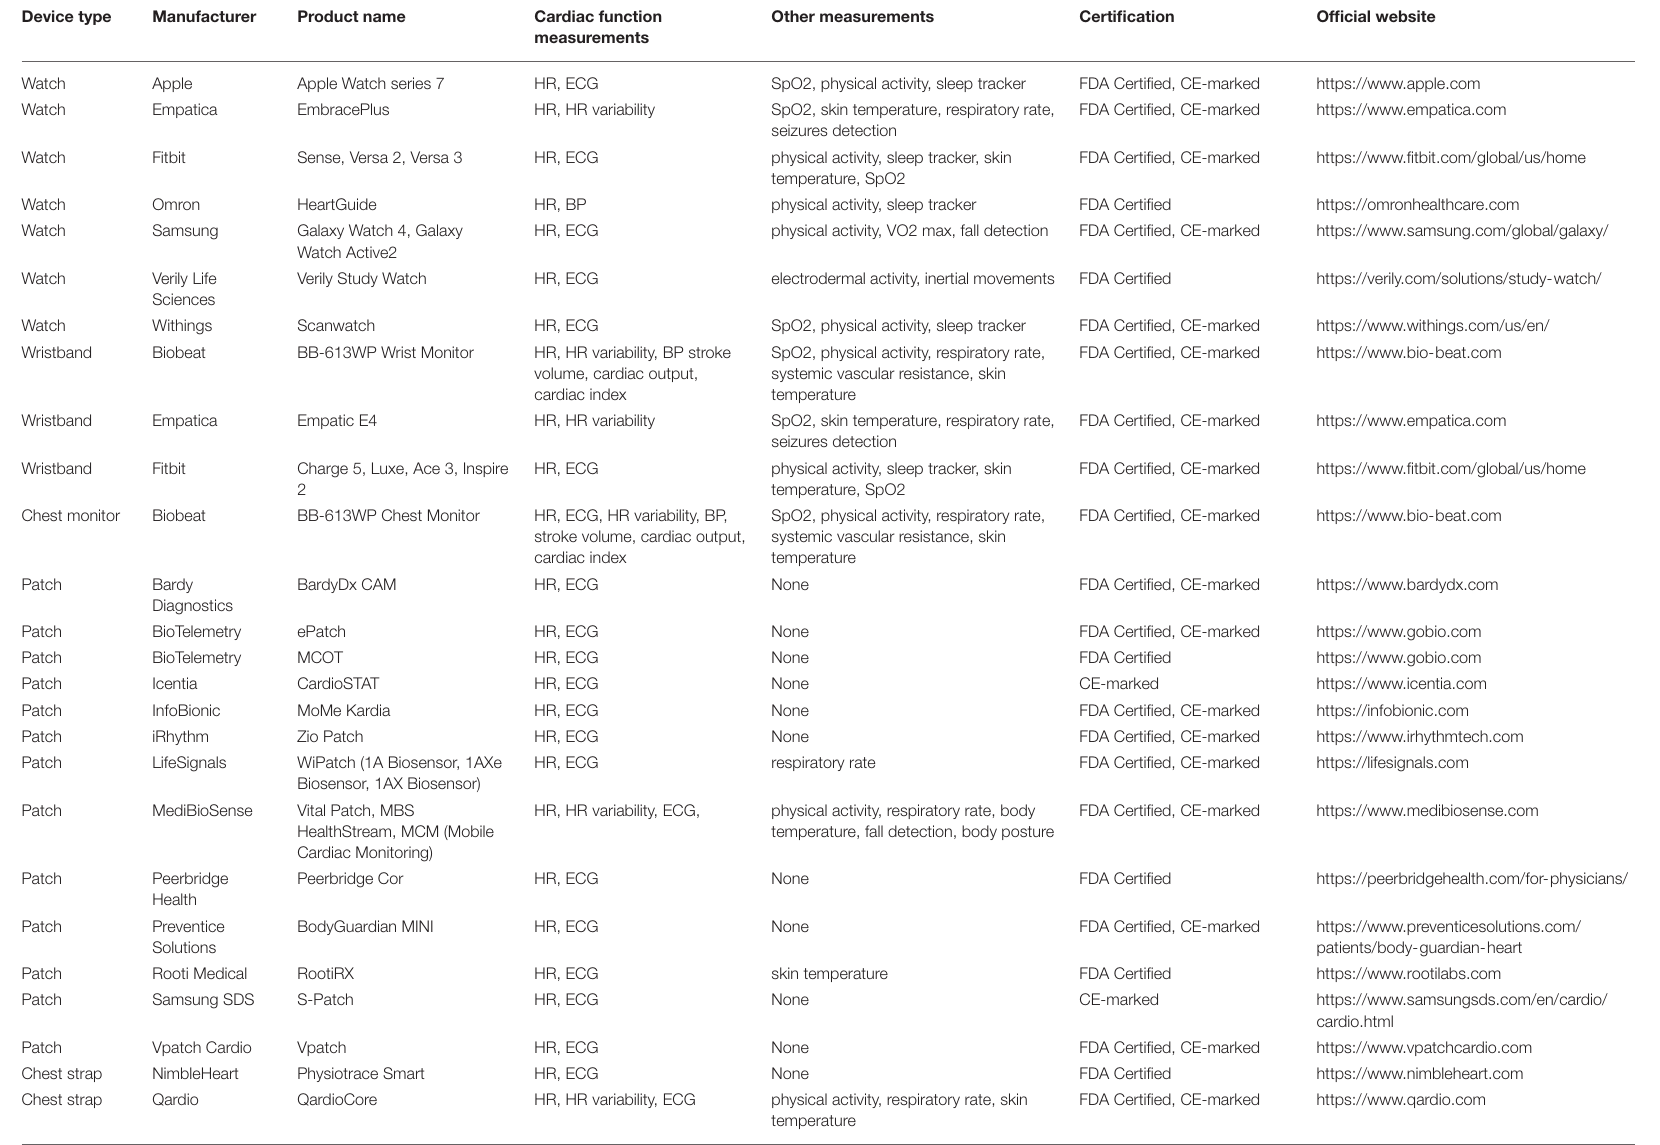
TABLE 1 | Wearable devices for heart rate and rhythm monitoring, certified by FDA or CE marked by the European authorities. Device